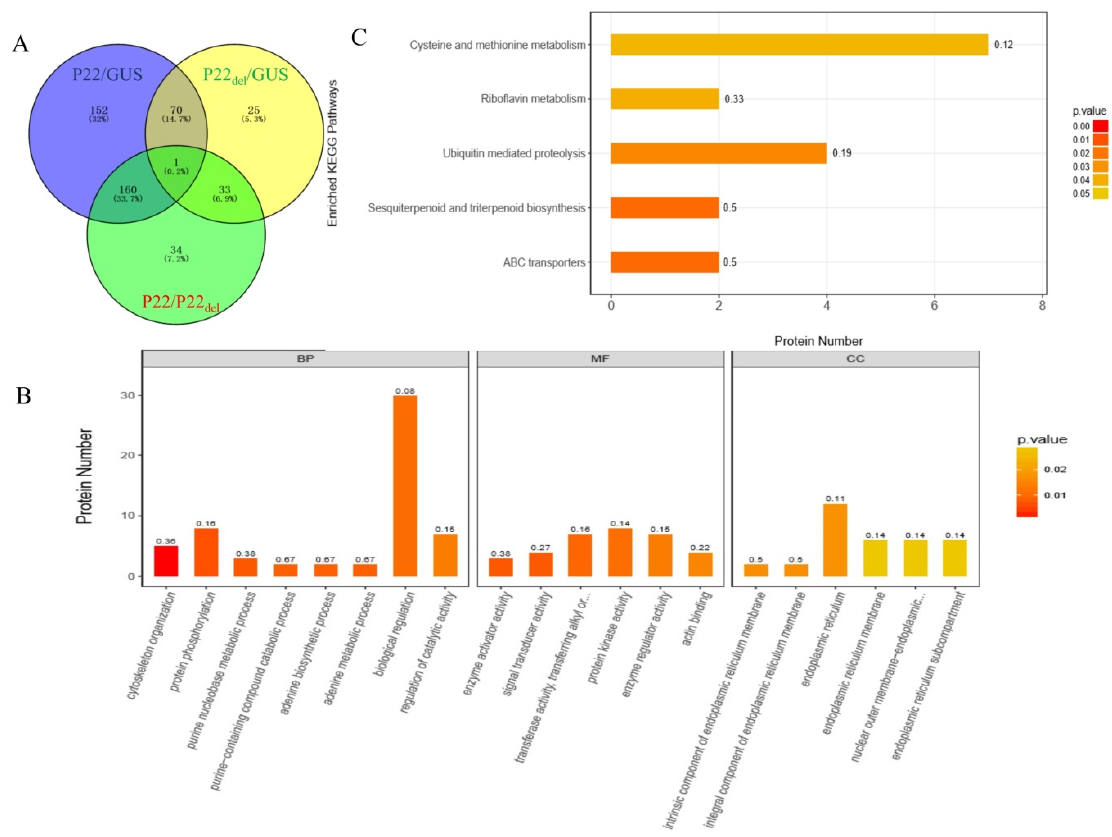
Figure 6. Proteomic analyses of potential proteins influenced by p22 and p22 del expression. ( A ) Venn diagram showing the number of differentially expressed proteins. ( B ) Top 20 enriched terms using gene ontology (GO) annotation analysis between p22 and p22 del treatments at P < 0.05. BP, biological process, MF, molecular function, CC, cellular component. ( C ) Enriched Kyoto Encyclopedia of Genes and Genomes (KEGG) pathways between p22 and p22 del treatments at P < 0.05.